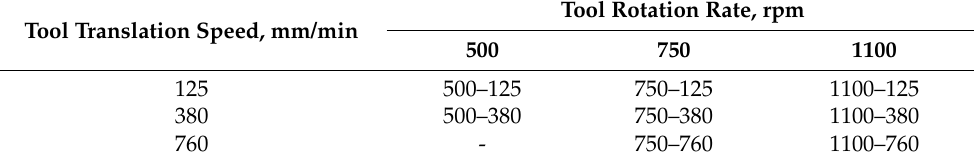
Table 1. Designation of welds. Tool Translation Speed,